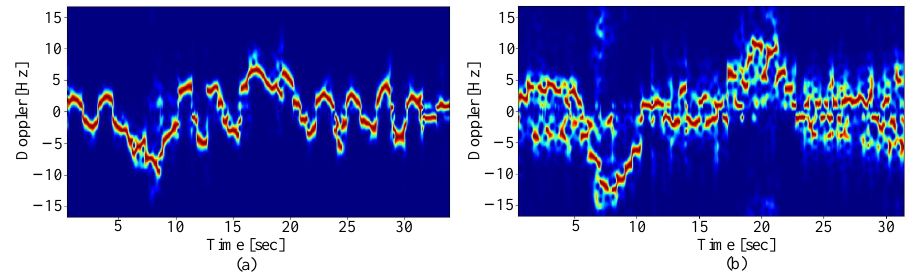
Figure 5. The spectrogram obtained by ( a ) a rigid target and ( b ) a person.